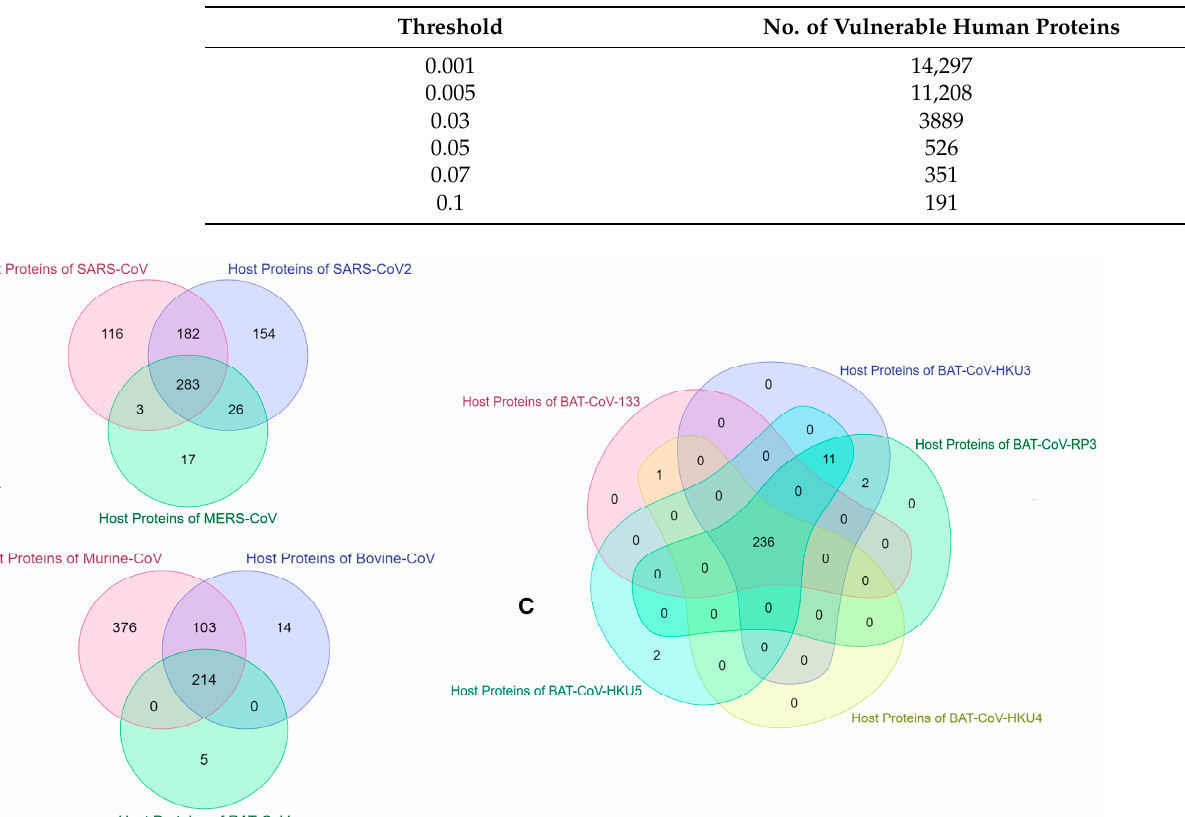
Figure 3. Venn diagram of the number of vulnerable host proteins obtained from host–pathogen interaction for all selected coronavirus organisms at 0.001 fuzzy threshold value. ( A ). Intersection of host protein identified from SARS-CoV-2, SARS-CoV, and MER-CoV. ( B ). The intersected host proteins from Murine-CoV, Bovine-CoV, and Rat Coronavirus. ( C ). Intersected host proteins from different viral organisms of Bat Coronavirus. 3.5. Identification of Potential Candidate FDA Drugs Concerning Vulnerable Host-Proteins Using Human–Coronavirus Family Interaction Network Analysis All level one human proteins of the coronavirus family are mapped with their match- ing medicines from DrugBank once the coronavirus family–human PIN has been created [114]. DrugBank is an online database that offers extensive information on medicines, drug-protein targets, and drug metabolism [115]. Most in-silico approaches used in drug